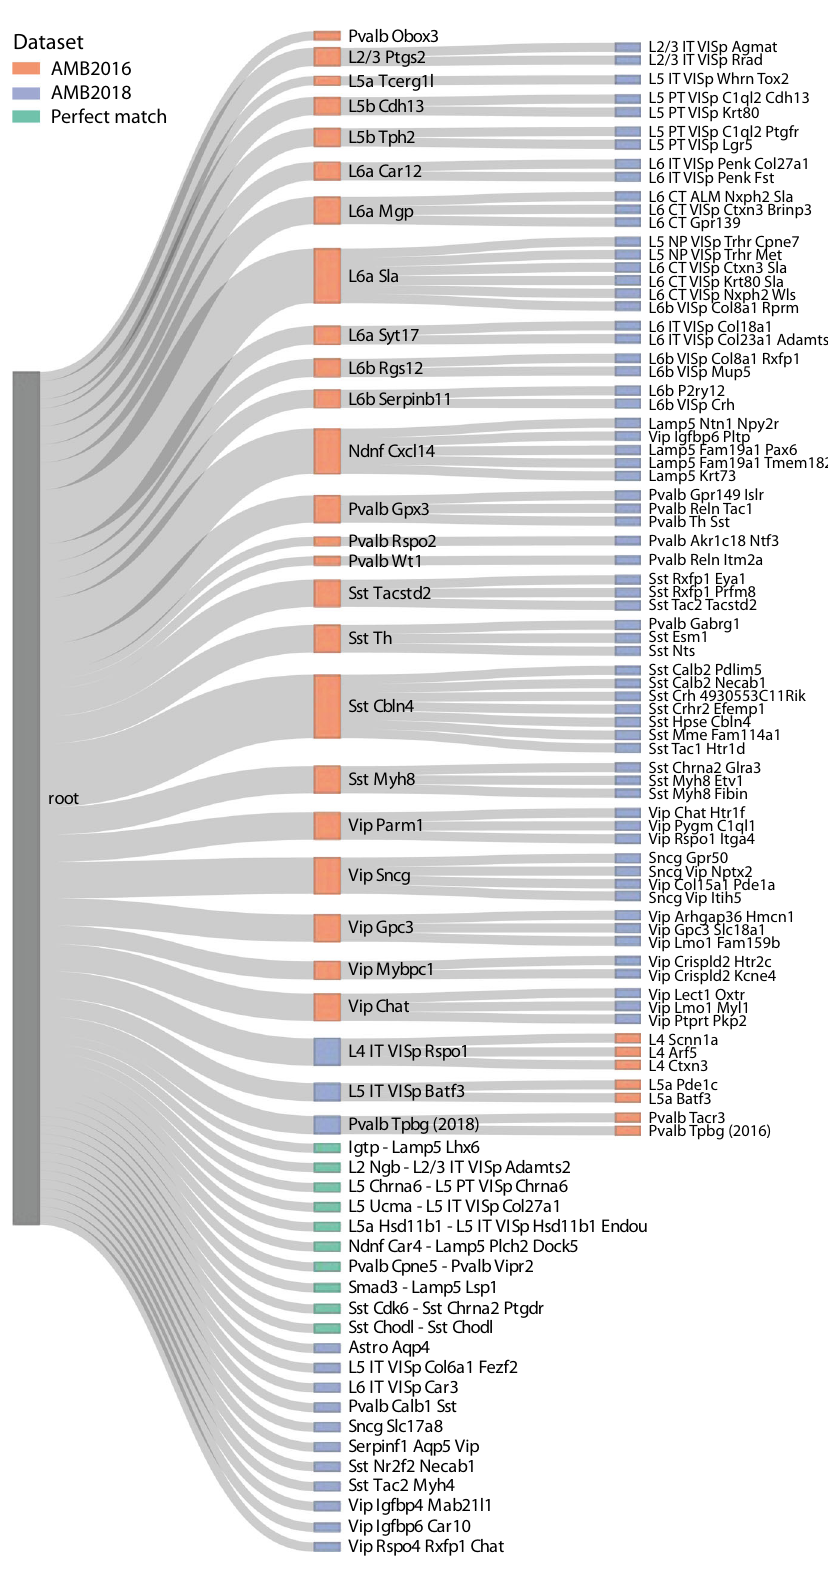
Fig. 6 Constructed hierarchy for the AMB datasets. Learned classi fi cation tree after applying scHPL with a linear SVM on the AMB2016 and AMB2018 datasets. A green node indicates that a population from the AMB2016 and AMB2018 datasets had a perfect match. Three populations from the AMB2018 dataset are missing from the tree: “ Pvalb Sema3e Kank4 ” , “ Sst Hpse Sema3c ” , and “ Sst Tac1 Tacr3 ”